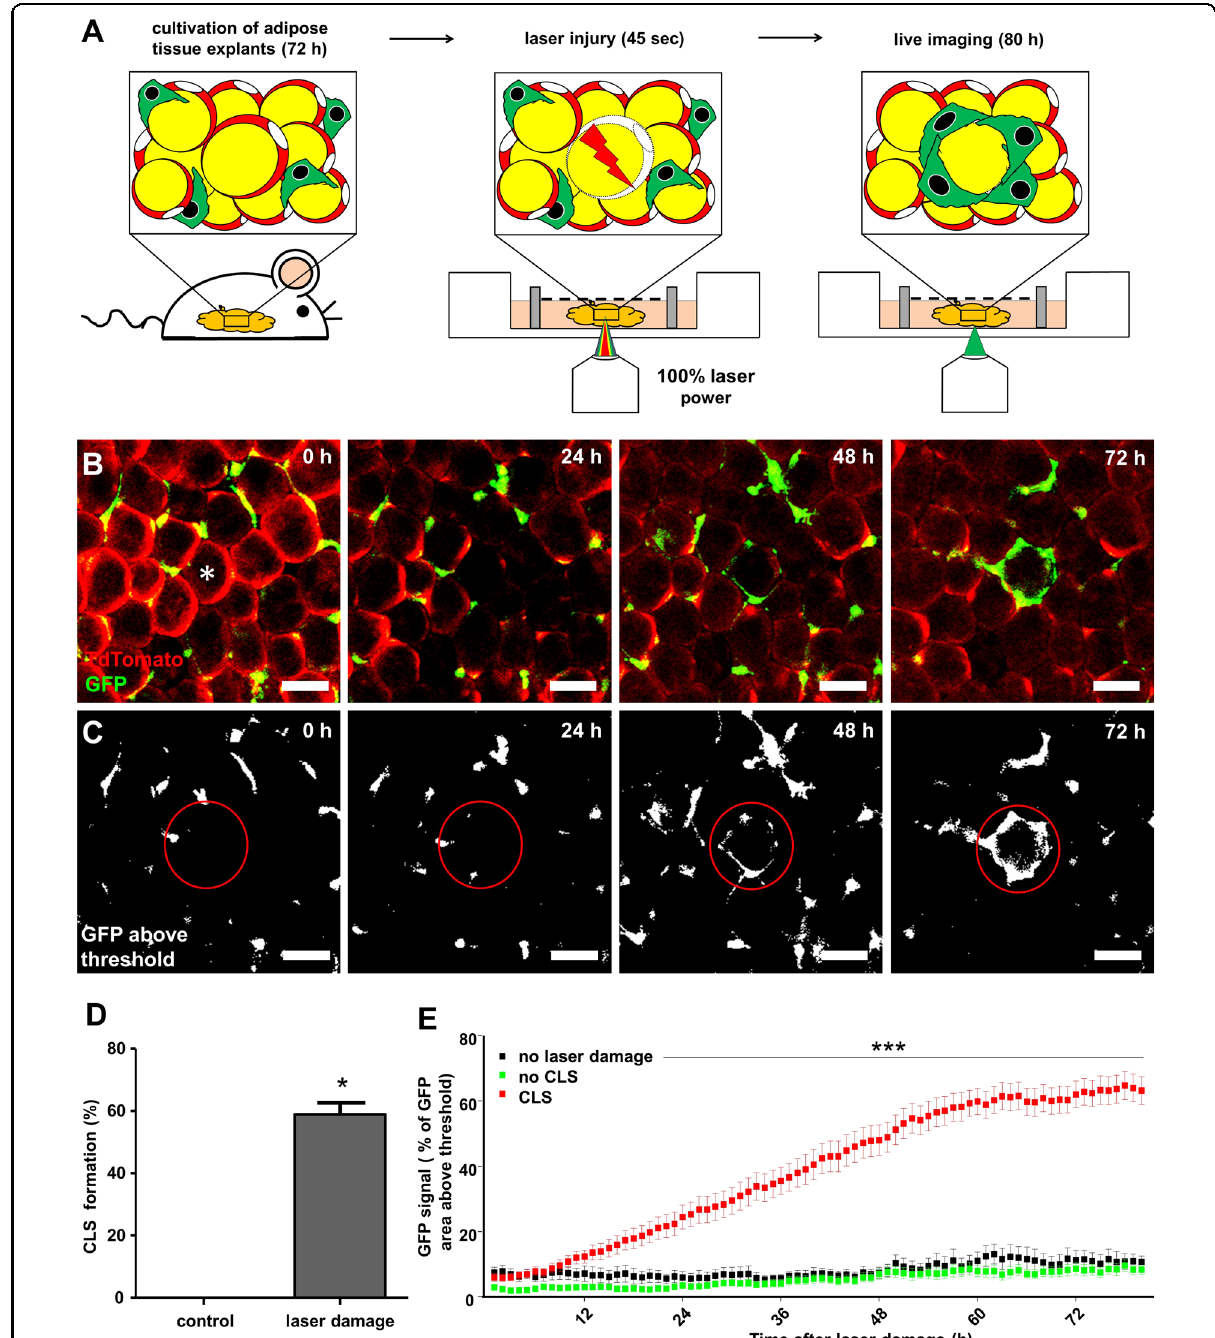
Fig. 2 Model of targeted adipocyte death by laser injury in living AT. A Scheme of laser injury protocol and B formation process of CLS after adipocyte death in AT explants from lean double reporter mice ( Csf1r- eGFP x Adipoq CreERT2:TDTO mice). Movie provided as supplemental online material. C , E GFP fl uorescence quanti fi cation in proximity to the targeted adipocyte ( E , no laser damage n = 13; no CLS n = 23; CLS formed n = 35; N = 5). D CLS formation after laser injury ( N = 5). Scale bars = 50 µm. * p < 0.05 and *** p < 0.001. Data presented as mean ±